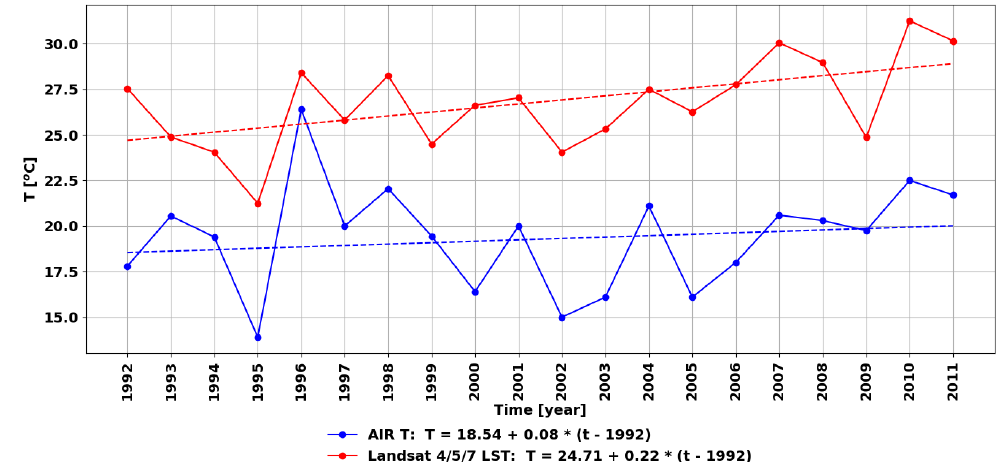
Figure 9. Comparison of the LST retrieved from the Landsat data with the air temperature measured at the Georgia State University weather